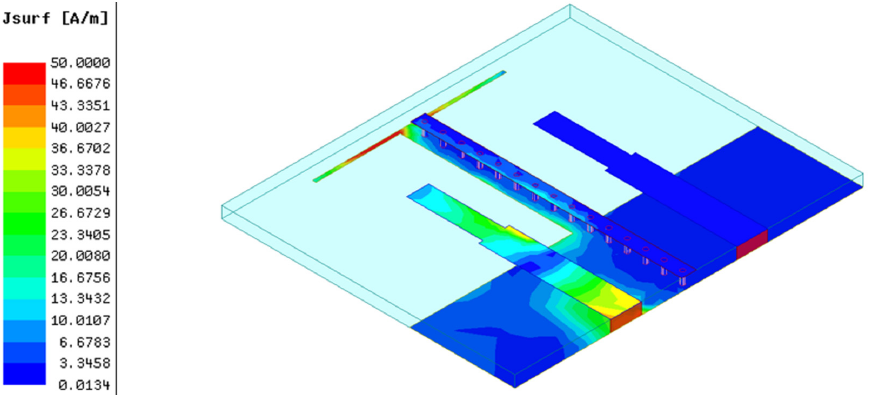
Figure 11. The current distribution of antenna